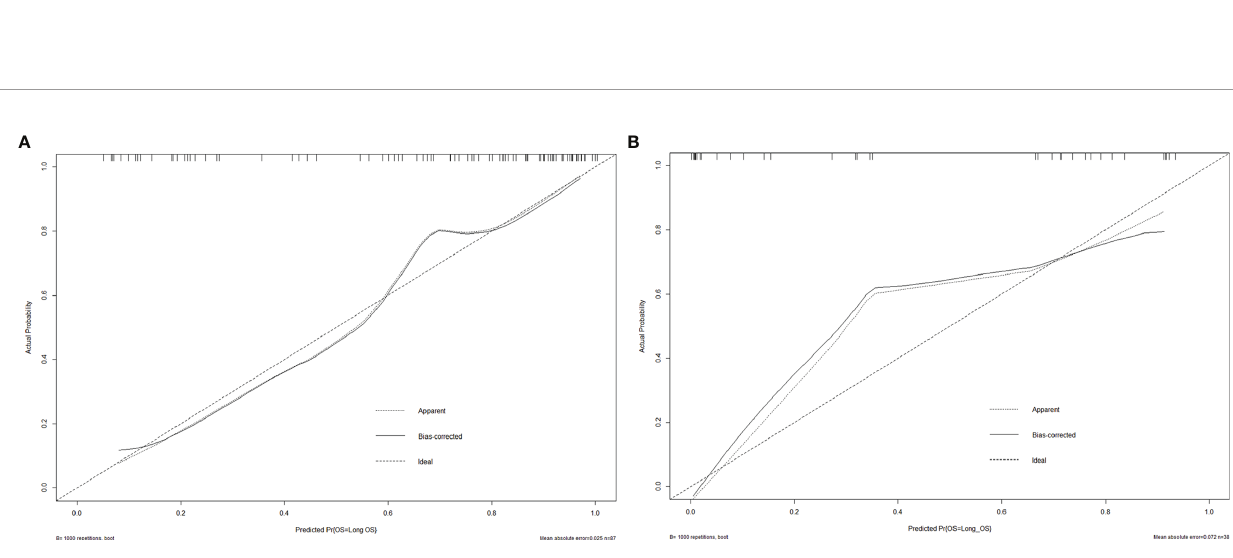
FIGURE 6 | The calibration curves of the radiomics nomogram for the training cohort (A) and validation cohort (B) . It showed the agreement between observed probabilities and the nomogram-estimated probabilities.